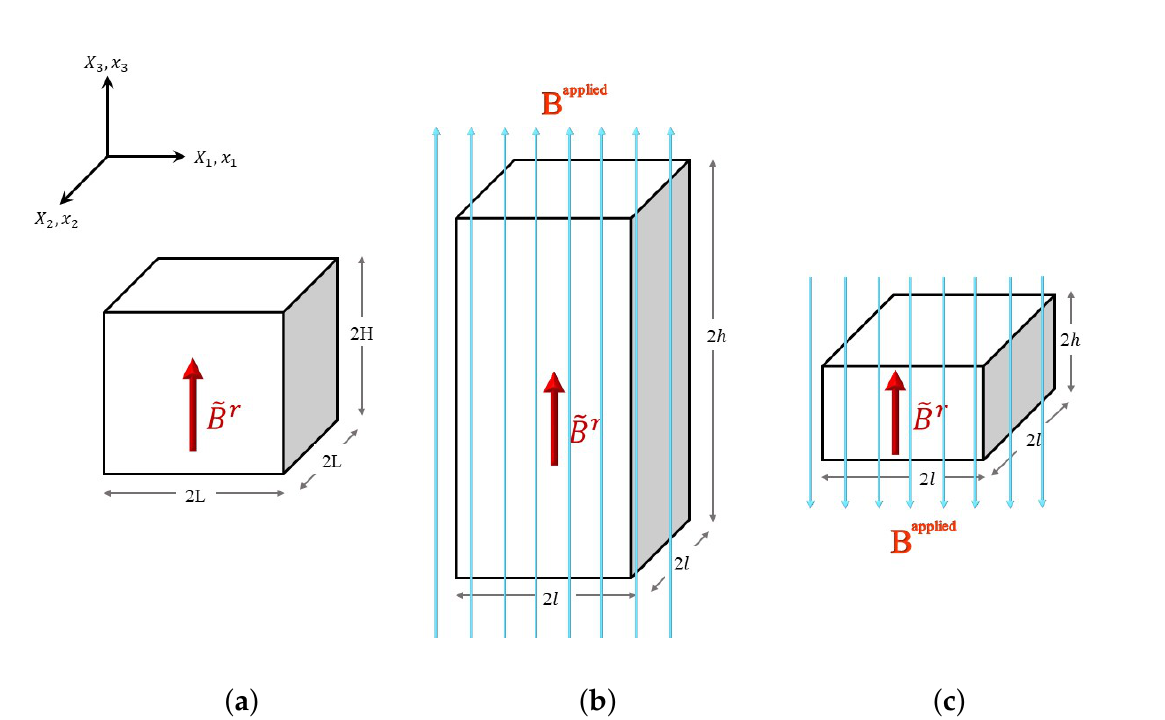
Figure 1. The schematic of a planar hard-magnetic soft actuator, ( a ) in the reference configuration with the dimensions 2 L × 2 L × 2 H in the X 1 , X 2 , and X 3 directions, respectively; ( b ) in the current configuration with the dimensions 2 l × 2 l × 2 h in the x 1 , x 2 , and x 3 directions, respectively, when the direction of the applied magnetic flux density is along the positive x 3 direction; and ( c ) in the current configuration with the dimensions 2 l × 2 l × 2 h in the x 1 , x 2 , and x 3 directions, respectively, when the direction of the applied magnetic flux density is along the negative x 3